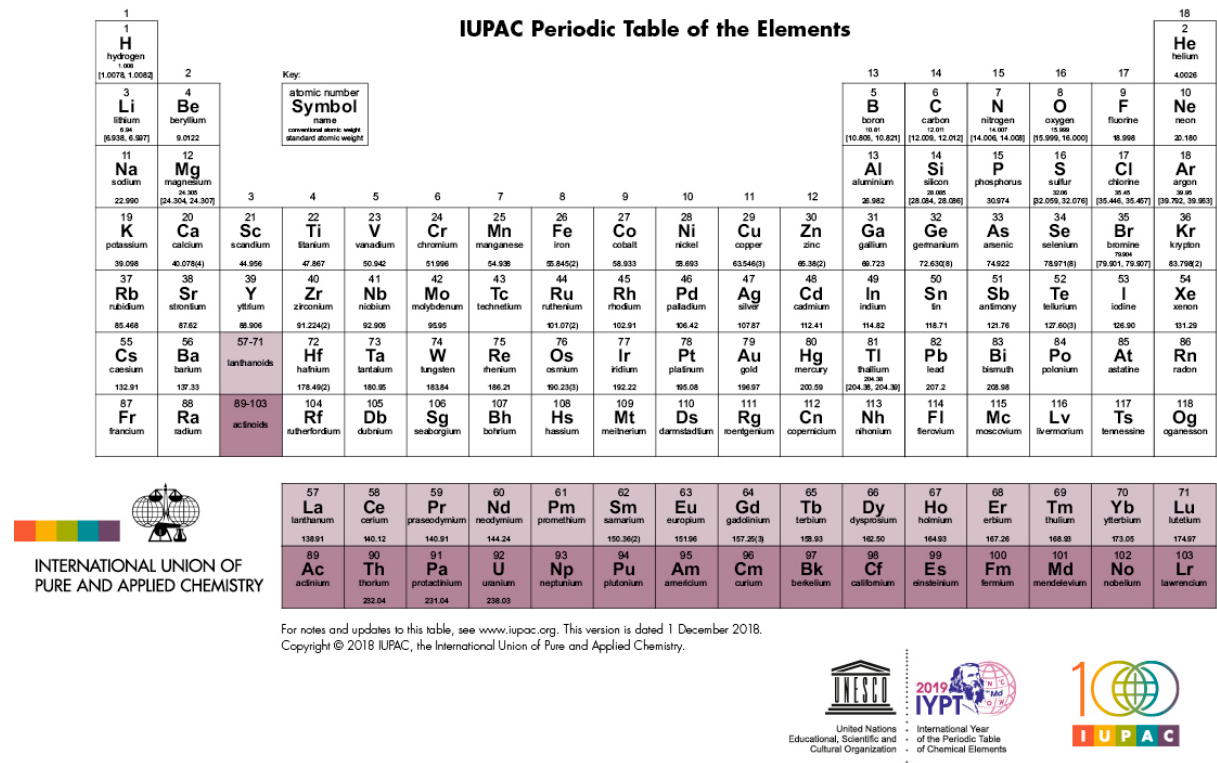
Figure 1. The periodic